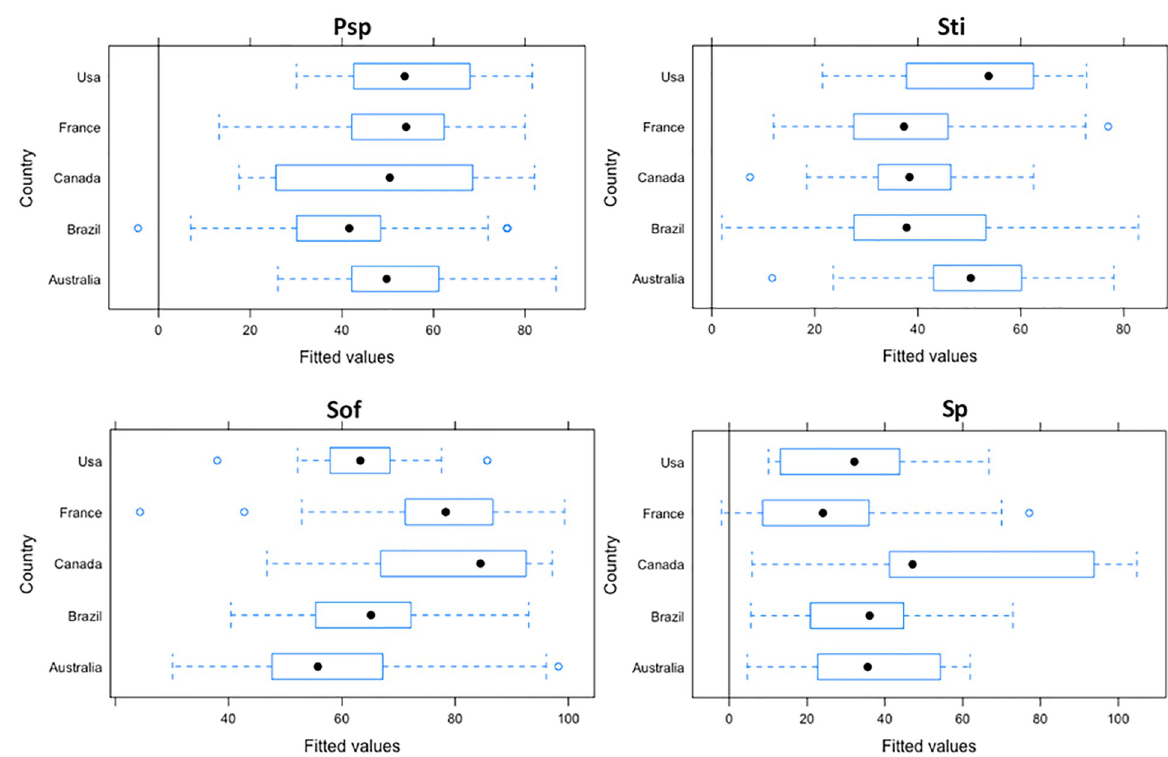
Fig 1. Variation of scores due to random effect among